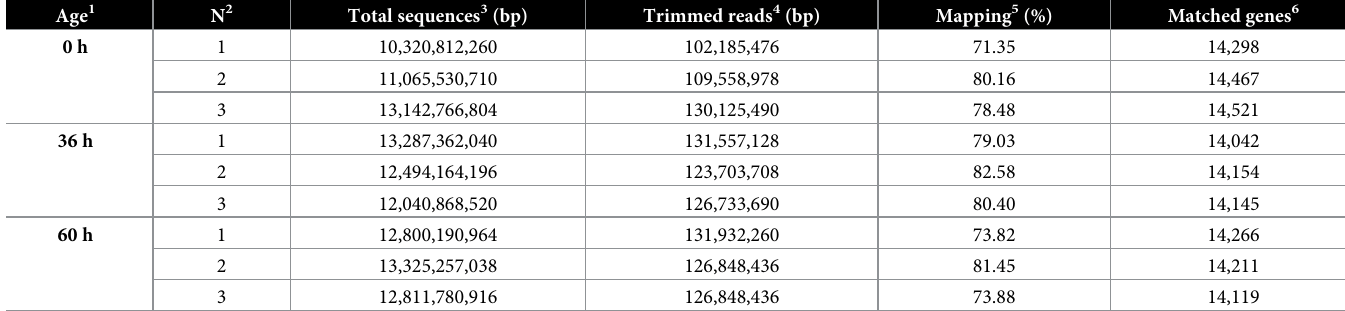
Table 1. Sequencing summary of F . occidentalis transcripts at different female